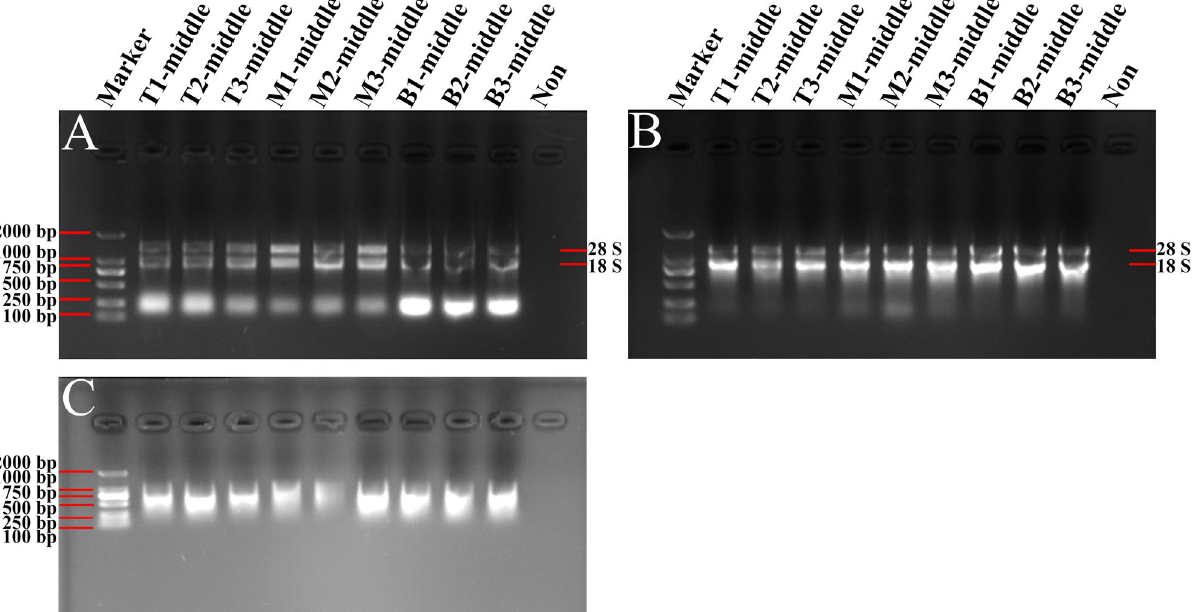
Figure 3. Gel images of total RNA from middle scales of Lilium davidii var. unicolor isolated using different protocols. The RNA samples extracted by the modified TRIzol method ( A ), Kit method ( B ) and CTAB method ( C ) were separated and analyzed in 1% agarose gels, respectively. Then the gels were visualized and exposed by Gel Imager System in different fields, and pictures were taken, respectively. The order of samples of each gel lane is as follows: Lane 1: DL2000 DNA marker; Lanes 2–4 are RNA isolated from top scales of Lilium ; Lanes 5–7 are RNA isolated from middle scales of Lilium ; Lanes 8–10 are RNA isolated from basal scales of Lilium ; Lane 11: Loading buffer solution without RNA to serve as a control. 28S and 18S represent the location of 28S and 18S rRNA